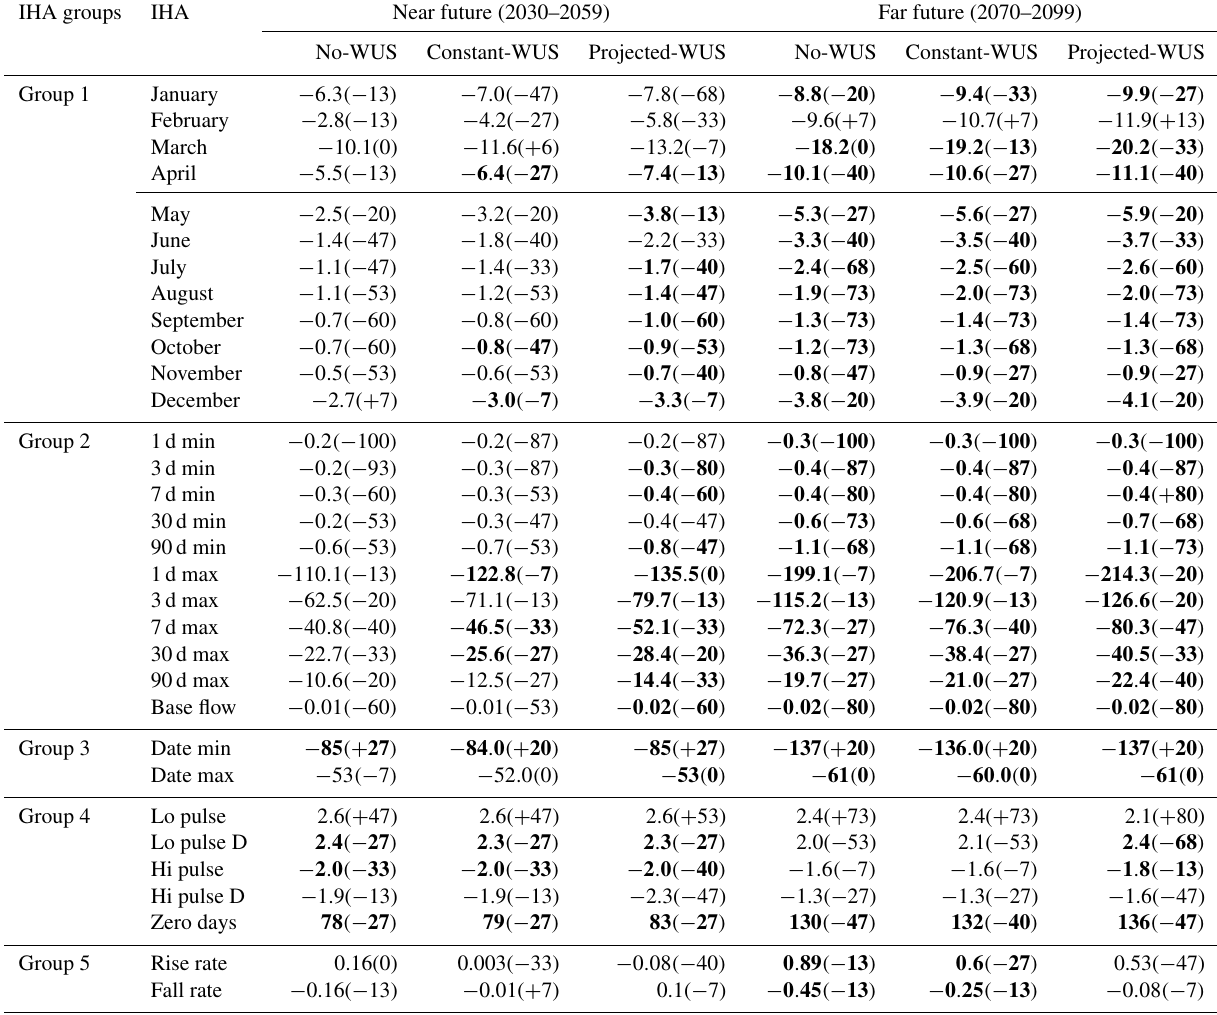
Table 9. Absolute change for Indicators of Hydrologic Alteration (IHA) (significant changes highlighted in bold digits) in the future under three different scenarios. No-WUS: the water use systems are not considered. Constant-WUS: the number of water use systems in the basin remains unaltered in the future. Projected-WUS: the number of water use systems increases linearly with population growth. The percentage of RVA (The Range of Variability Approach) deviation is shown in